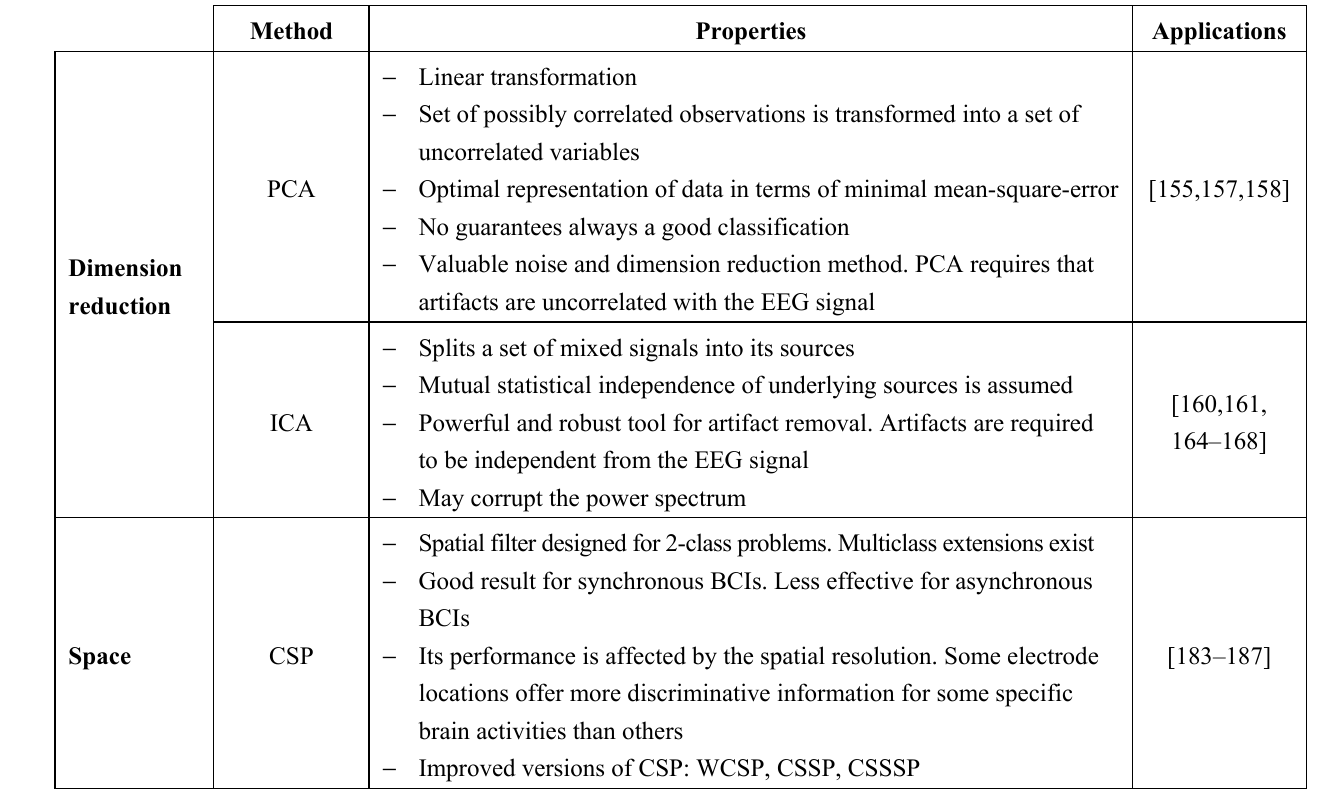
Table 6. Summary of feature extraction